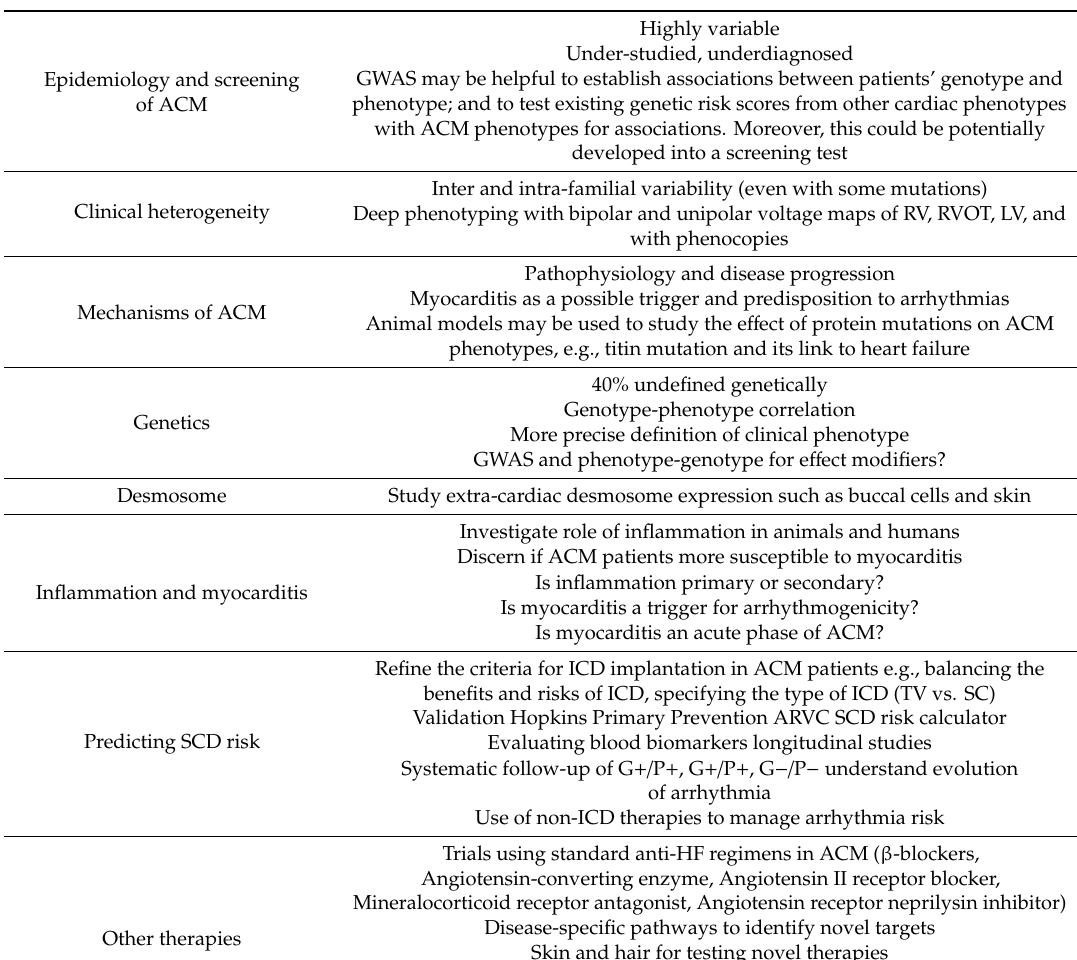
Table 3. Future directions: research priorities in